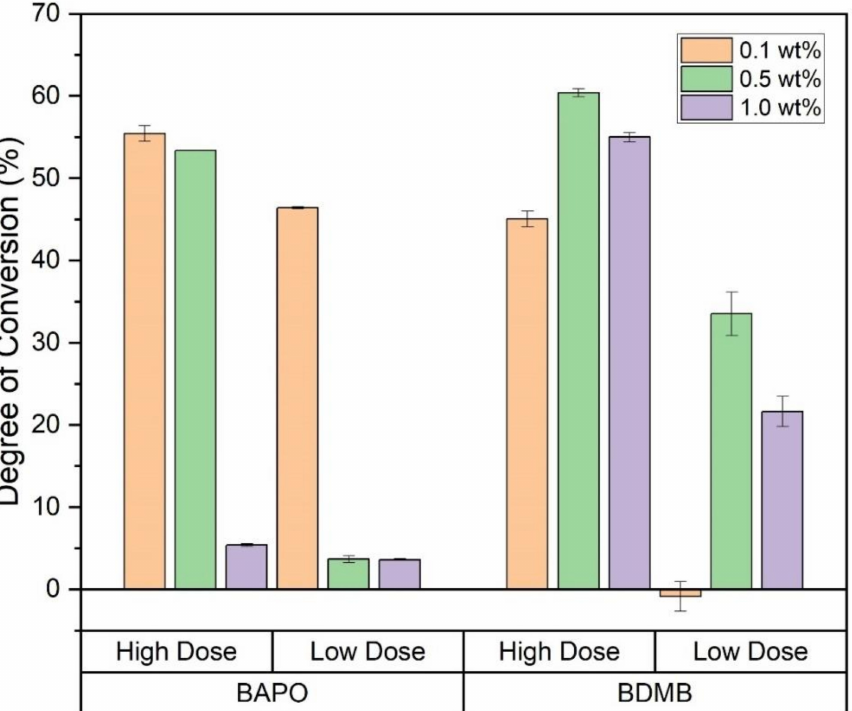
Figure 10. DC for all six formulas as measured at a 3-mm depth, with Low Dose irradiation of 1.4 J/cm 2 or High Dose irradiation of 5.5 J/cm 2 . Error bars indicate +/ − one standard